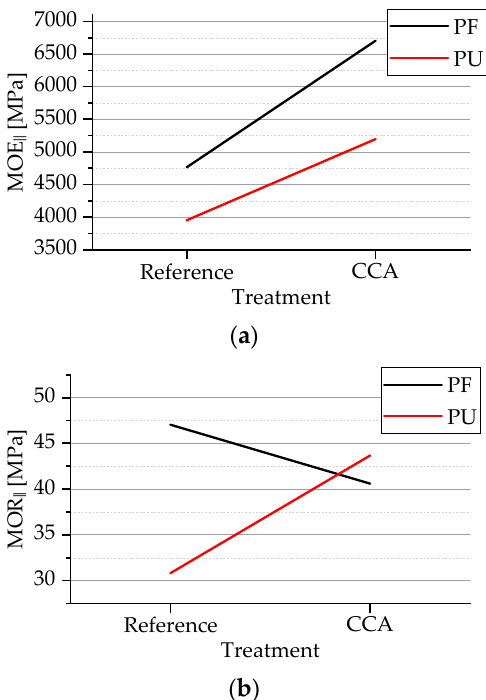
Figure 7. Interaction graphics: parallel static bending ( a ) MOE ∥ and ( b ) MOR ∥